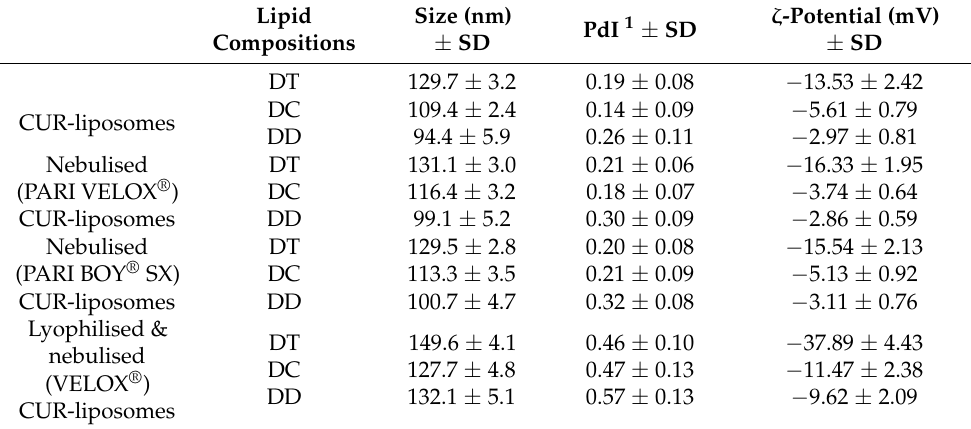
Table 2. DLS analysis of DT (DPPC:TEL), DC (DPPC:Chol) and DD (DPPC:DOPE). Curcumin-loaded liposomes nebulised via vibrating-mesh (PARI VELOX ® ) and air-jet nebulisation (PARI BOY ® SX) were compared with each other, respectively. Unnebulised curcumin-loaded liposomes were used as control. Values of particle size represent the distribution by intensity. Independent formulations were used to measure the triplicates and all results were expressed as mean ± standard deviation. Lipid